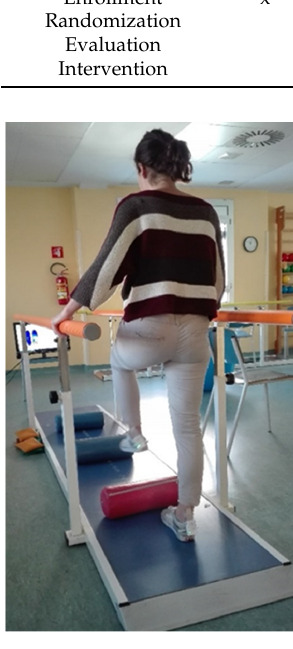
Figure 2. Experimental setting.